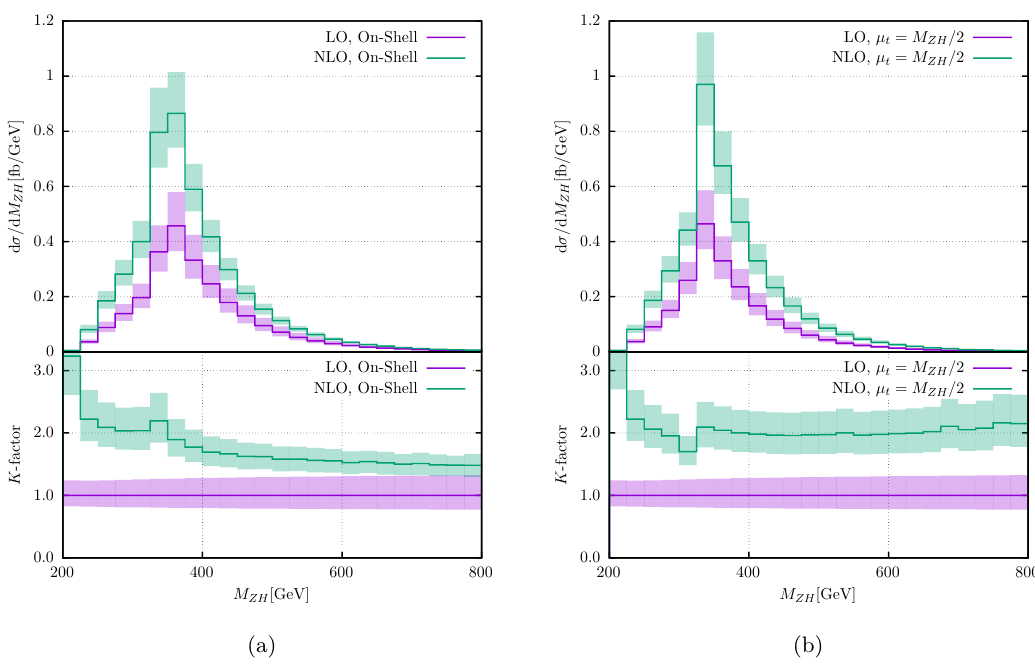
Figure 3. Invariant-mass distribution at LO (magenta) and NLO (green) for the OS scheme (a) and the MS scheme with the choice µ t = M ZH / 2 (b). The scale uncertainties are depicted as shaded bands. The lower panels show the K